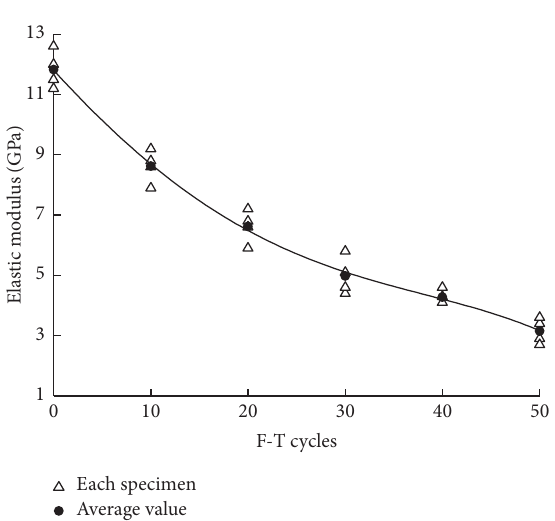
Figure 8: Young’s modulus variations after F-T